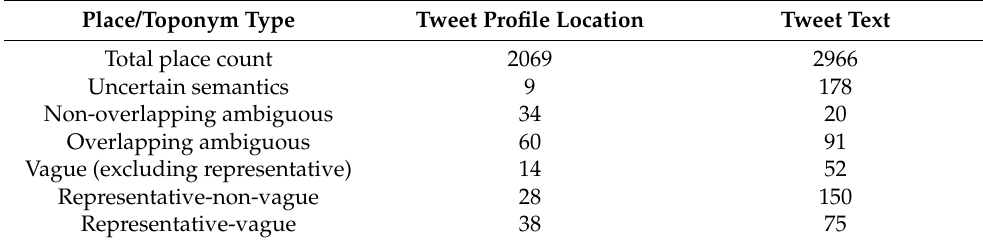
Table 5. Frequency of special tags and total number of place names in the